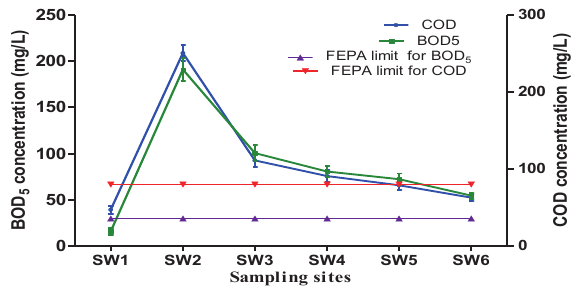
Figure 3 and COD concentrations of leachate and sampled Figure 3: The BOD 5 surface water in this study as compared to the standard limits set by FEPA.